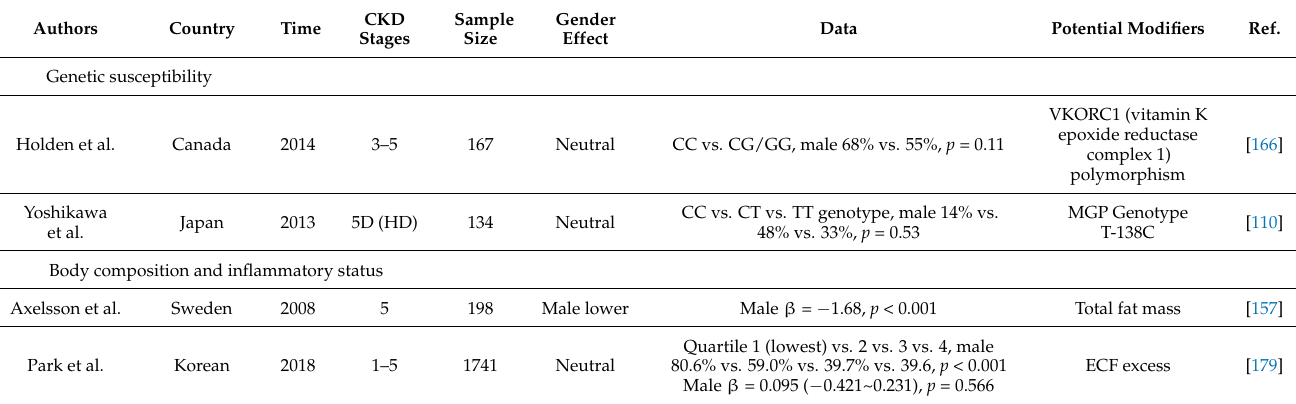
Table 1. Potential gender-related modifiers of vascular calcification in existing